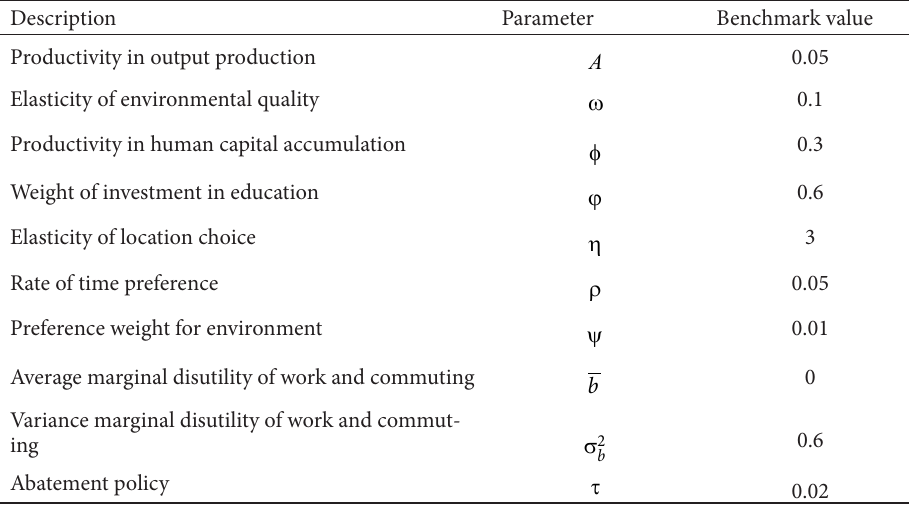
Table 1. Benchmark parameter